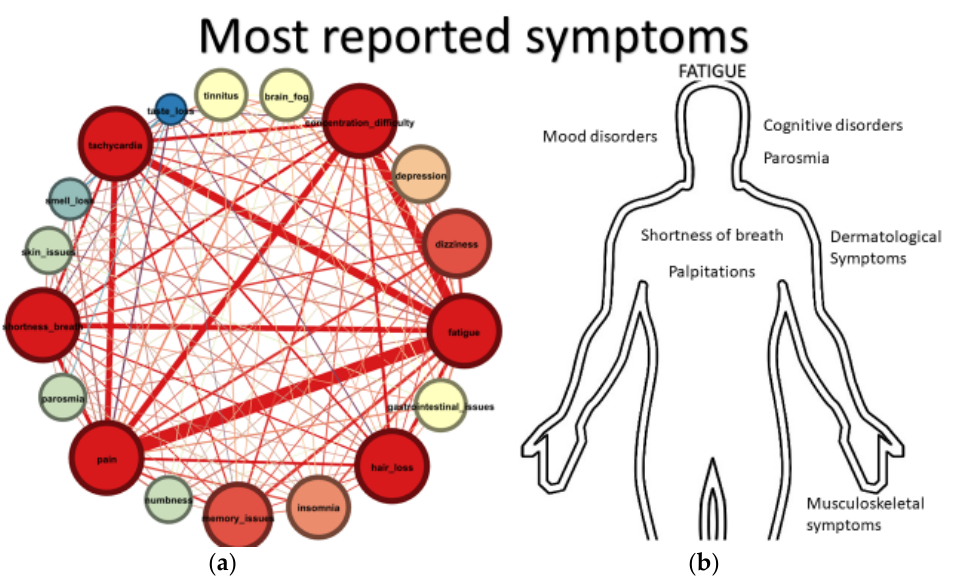
Figure 3. ( a ) Network Analysis graph of persistent symptoms. Larger nodes imply higher degree centrality. ( b ) Most frequently reported symptoms in Greek Long COVID society (LCGr). Despite the variation in the initial severity of acute phase, patients with initial mild